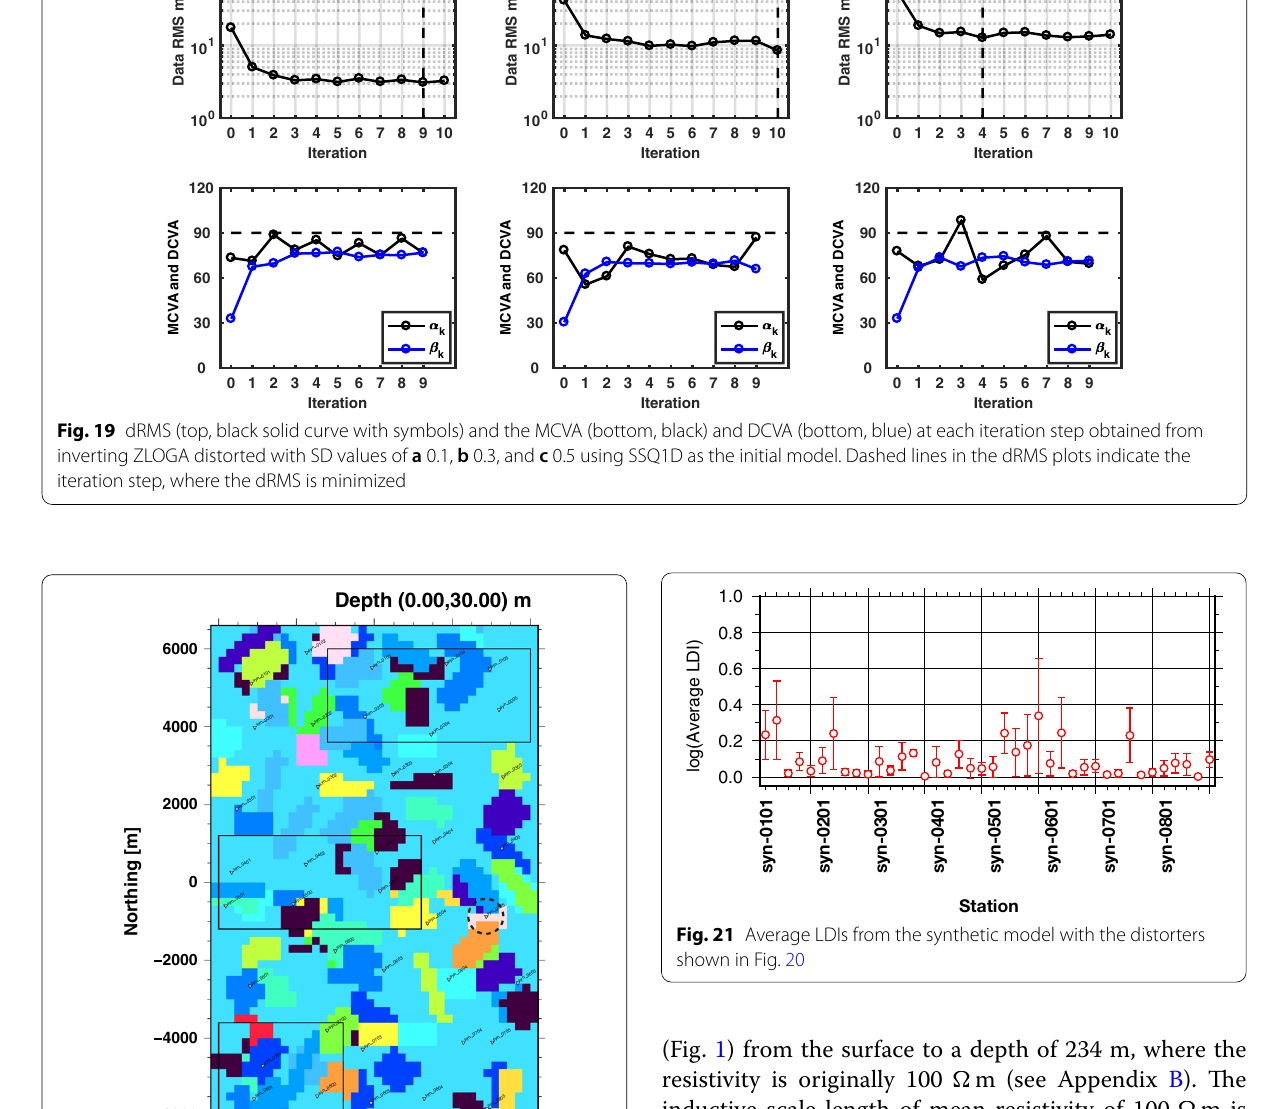
(Fig. 1) from the surface to a depth of 234 m, where the (cid:31) m resistivity is originally 100 (see Appendix B). The (cid:31) m inductive scale length of mean resistivity of 100 is 4 estimated as about 50 m with a period of 10 − s, which is much smaller than the typical scale of distorters given in the model. Thus, the distortion due to the oblong distorter model is expected to be inductive at shorter periods. Synthetic impedances were calculated from the oblong model. The strength of distortion at each station is indi- cated by the average LDI (Rung-Arunwan et al. 2017) in Fig. 21. The average LDI suggests that station syn-0505 is strongly distorted. This may be due to the station being located near a distorter with a strong resistivity contrast (Fig. 20). At this station, the PT elements in arctangent